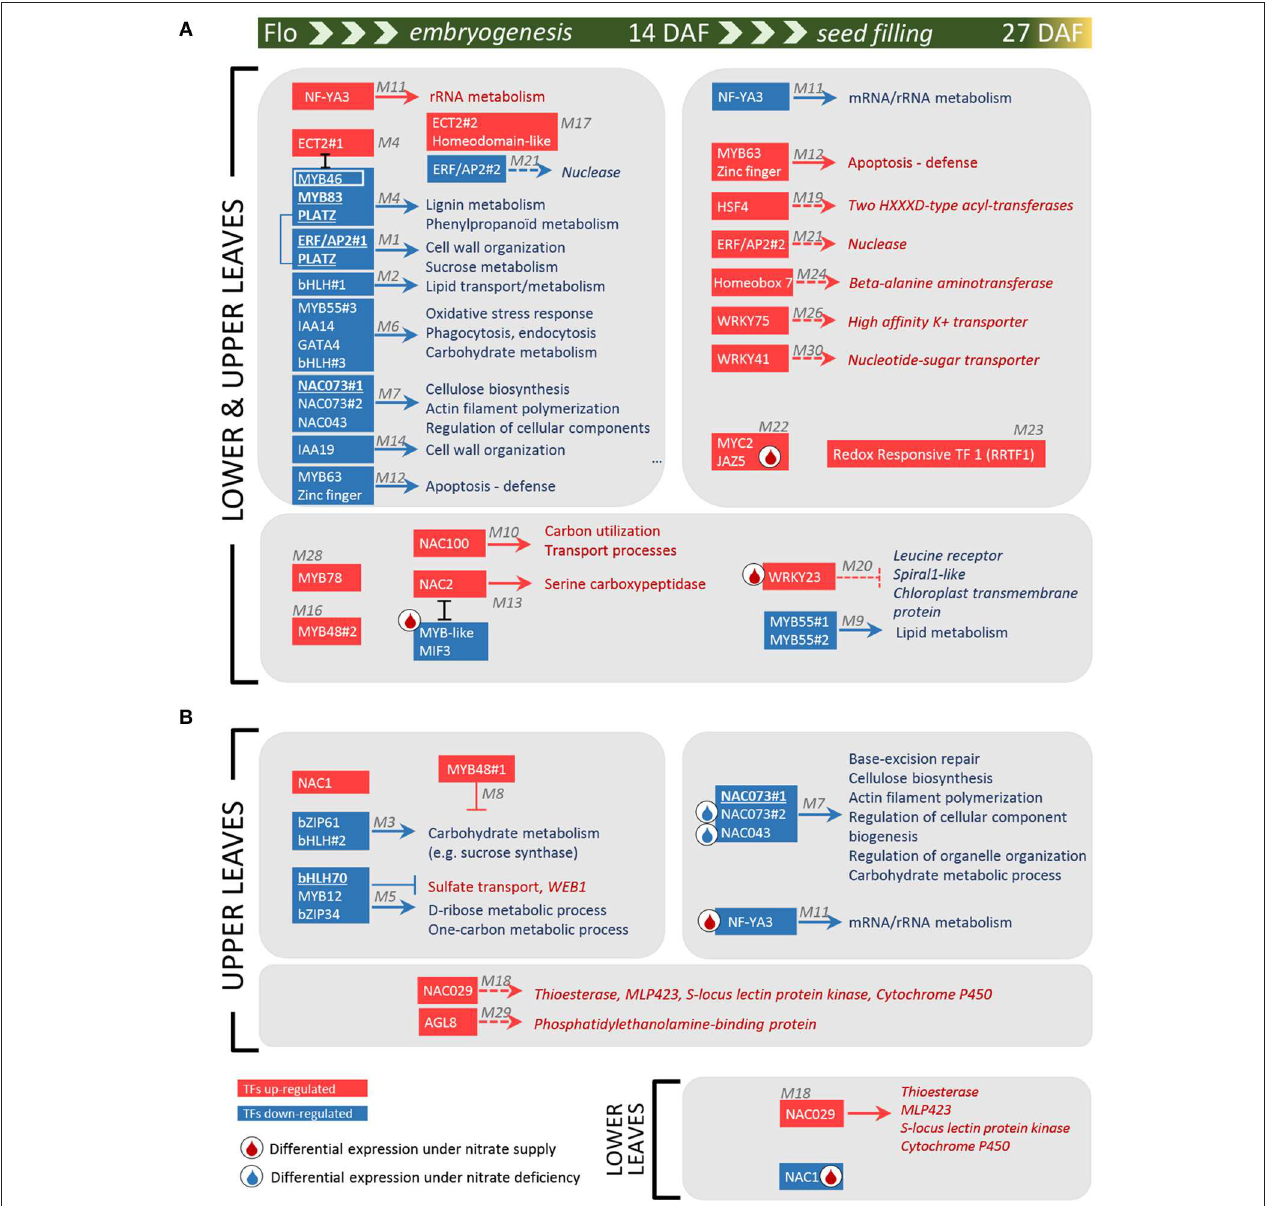
FIGURE 5 | Diagram of TF-related co-expression modules in pea leaves during embryogenesis and seed filling. Red and blue rectangles correspond to TFs up- and down-regulated, respectively, during the time course of nutrient remobilization: from the beginning of flowering to 14 DAF (left panel), from 14 to 27 DAF (right panel) or throughout the time course (large panels). The arrows indicate a co-expression between TFs and biological processes (TopGO annotation, Table S8 ) or genes (in italic) was identified in P-REMONET (corresponding modules in gray). ⊥ and H indicate negative expression correlations between genes. The colors of the TFs and related processes indicate the genes were up- (red) or down- (blue) regulated during the time course in both lower and upper leaves (A) or in specific leaf types (B) . TFs in bold and underlined have shared putative targets in the co-expression networks from M. truncatula and pea. A droplet indicates significant variations in gene expression specifically in response to nitrate supply (red) or deficiency